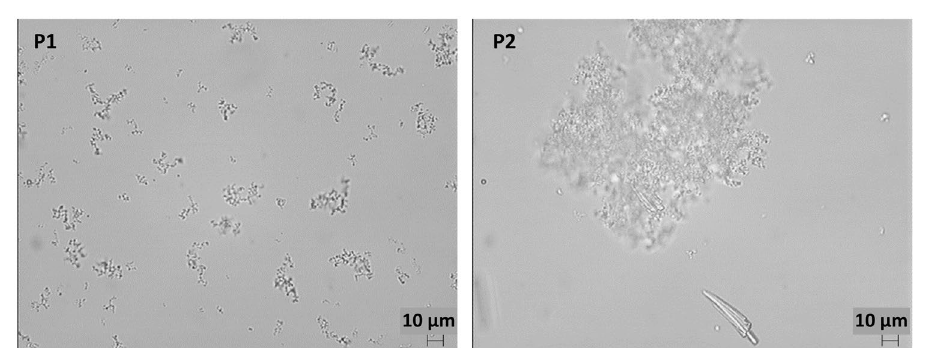
Figure 4. Amorphous precipitate of organic calcium (90 mmol/L) and organic phosphate (70 mmol/L) in PN solutions P1 and